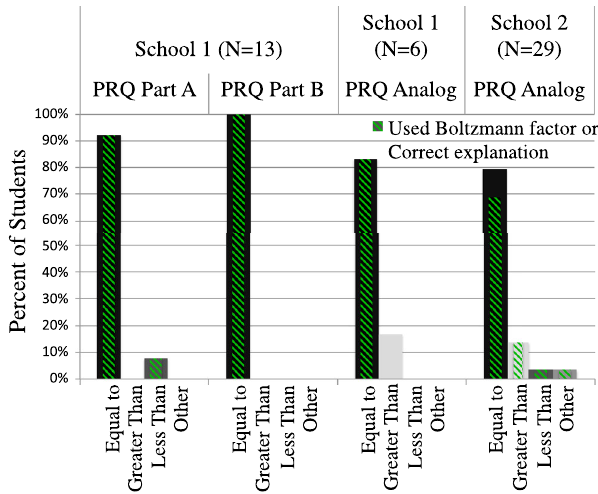
FIG. 5. Post-tutorial results from PRQ and PRQ Analog, administered during course examinations. The green diagonal stripes indicate the students who used the Boltzmann factor or stated that the energy of the ground state was irrelevant (in part B) to obtain their chosen answer(s). For the PRQ Analog, “ Equal to ” corresponds to choice II, “ Greater than ” to choice I, “ Less than ” to choice III, and “ Other ” to choice IV. Data are shown for students who completed the PRQ pretest, participated in the Boltzmann Factor tutorial, and completed either the PRQ or the PRQ Analog exam